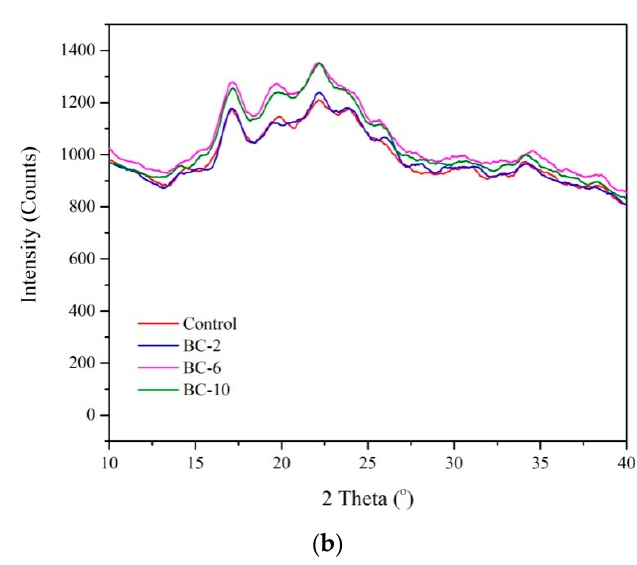
Figure 3. X-ray diffraction (XRD) patterns of ( a ) fibers, and ( b ) control and biocomposite films.